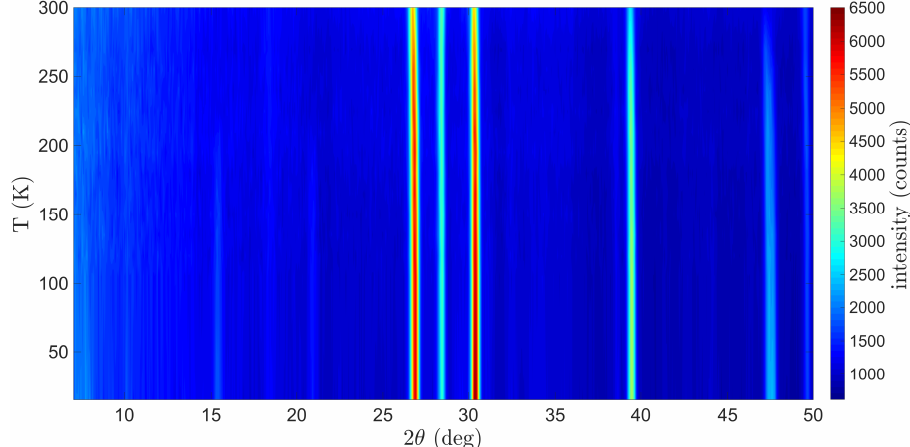
Figure 5: Thermodiffractogram showing the magnetic phase transitions at = 274 K and T = 204 K (note that the temperature values were derived from T N 1 N 2 the single-crystal experiments). The onset of the commensurate ferrimagnetic struc- ture is manifest by an increase of intensity on e.g. the reflections at 2 θ values of 26.8 ◦ , 30.4 ◦ and 39.4 ◦ . The transition into the low-temperature magnetic phase is accompanied by the appearance of new satellite peaks, e.g. at 2 θ = 15.4 ◦ and 21.0 ◦ .